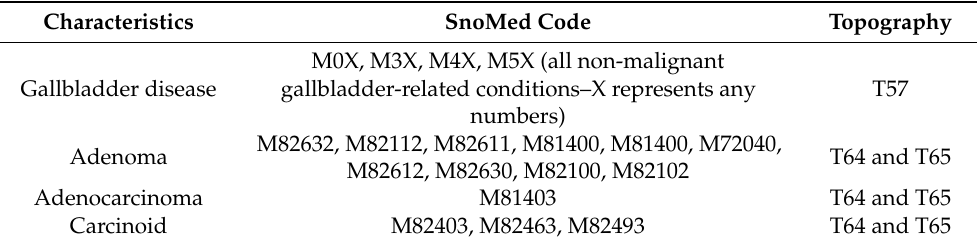
Table A1. Definition of exposure and outcomes from